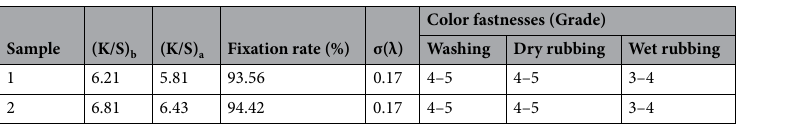
Table 5. Characterization of the dyed